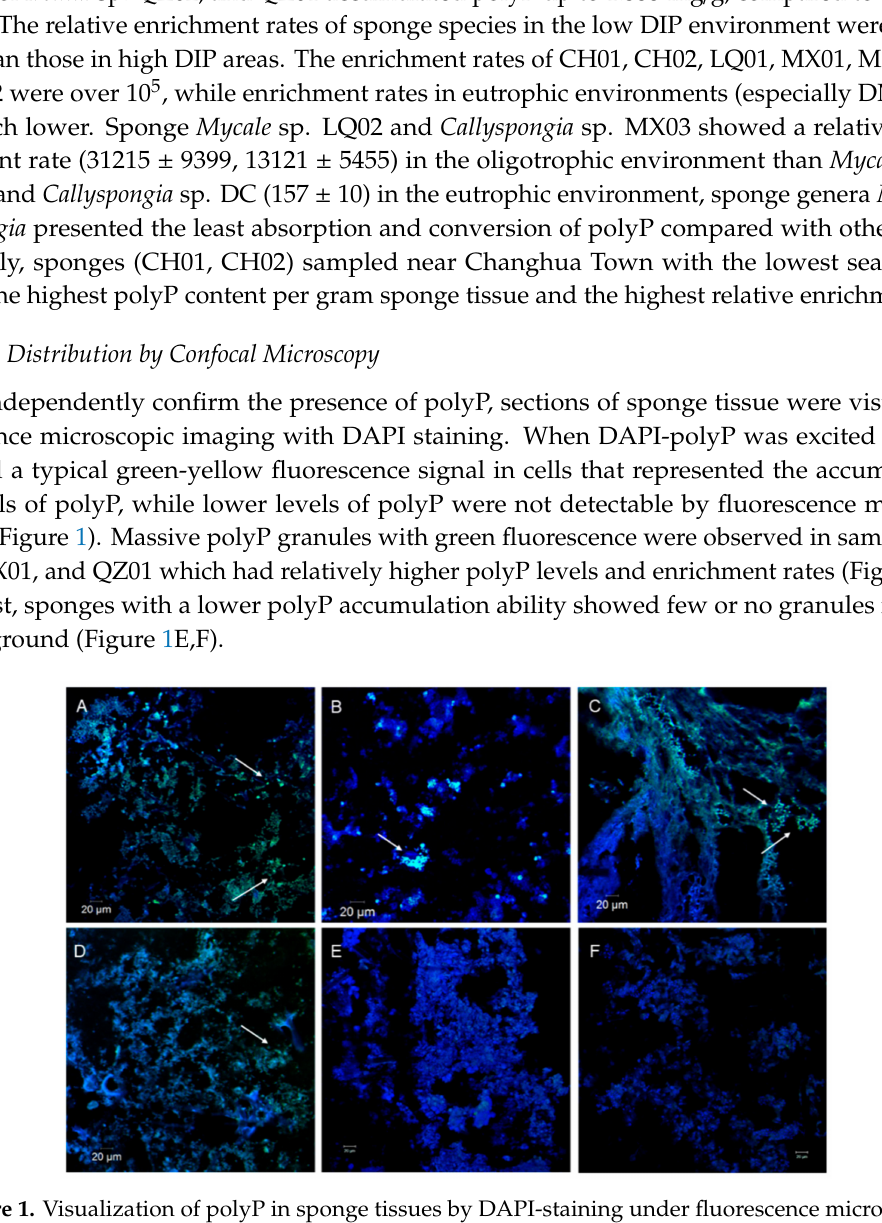
Figure 1. Visualization of polyP in sponge tissues by DAPI-staining under fluorescence microscopic imaging. PolyP granules indicated by arrows. ( A ). CH01, ( B ). CH02, ( C ). MX01, ( D ). QZ01, ( E ). DT, ( F ). DM. Samples in ( A–D ): from the oligotrophic environment; Samples in ( E , F ): from the eutrophic environment. Scale bar: 20 µ